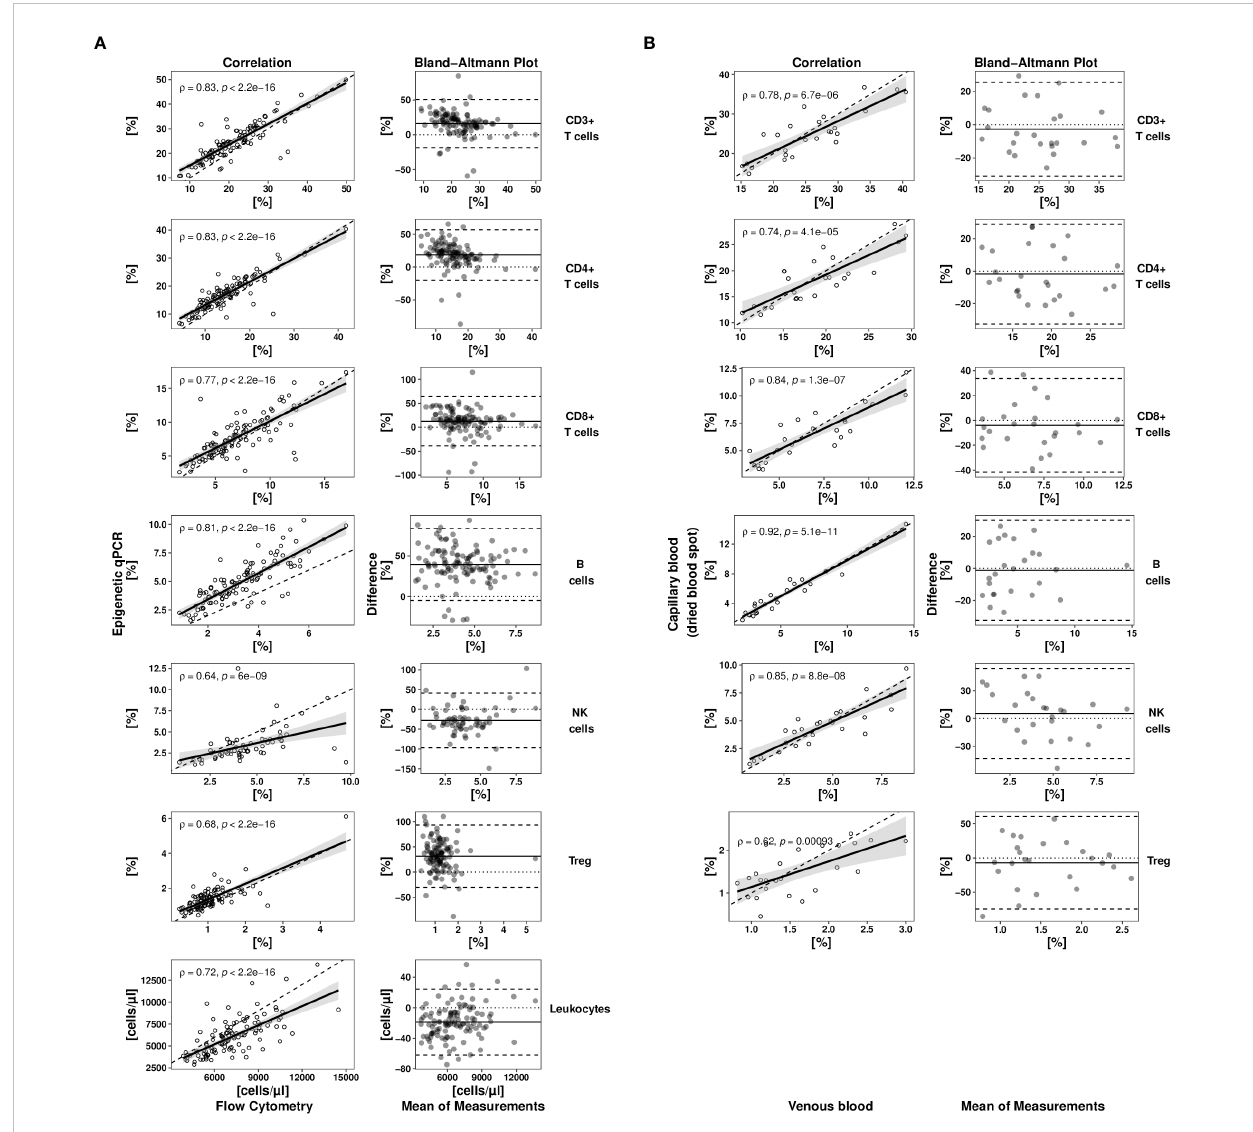
FIGURE 1 Method comparison studies for epigenetic cell quanti fi cation. (A) A full method comparison study of epigenetic qPCR- and fl ow cytometry-based cell quanti fi cation in venous whole blood samples of healthy donors (n = 113) was undertaken for different cell types. (B) Immune cell counts (epigenetic qPCR) in capillary blood (stored as dried blood spot (DBS)) of healthy donors (n = 25) were compared to matched venous blood samples (liquid). Each method comparison is displayed by a scatterplot (left side) and a tukey mean difference plot (right side). Scatter plot showing immune cell frequencies determined by epigenetic qPCR plotted against fl ow cytometrically determined relative or absolute cell numbers (dashed line: bisectrix, solid line: linear regression line (y~x) with 95% con fi dence interval). Spearman (rho) coef fi cients with corresponding p values are shown in correlation plots. Tukey mean difference plot shows difference normalized by the mean of both methods for each sample expressed as percentage (dashed lines indicate -/+ 1.96-times standard deviation of relative difference, solid line indicates systematic error (bias)). Treg, regulatory T cells; NK cells, CD56dim natural killer